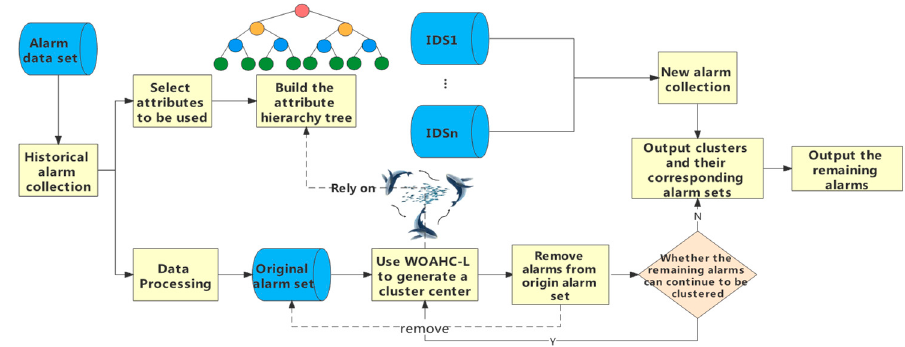
Figure 12. Alarm reduction framework flow chart based on WOAHC-L.